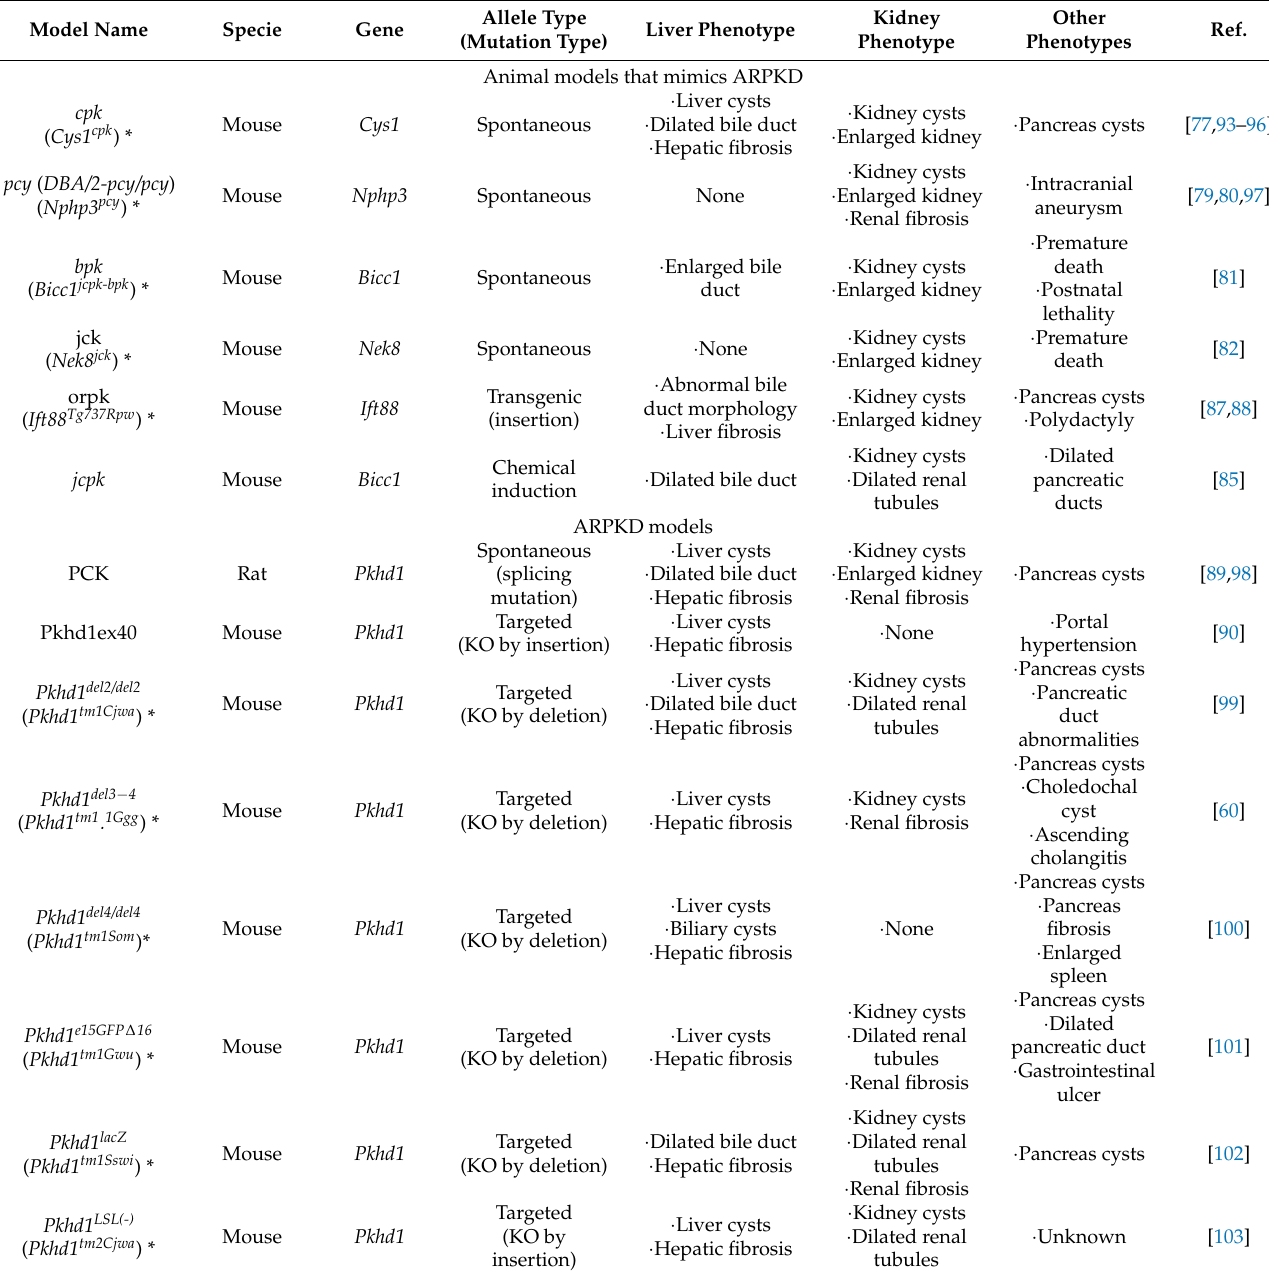
Table 1. List of current animal models of ARPKD, or that mimics it phenotype. Animal models were ordered from least to most recent, according to published